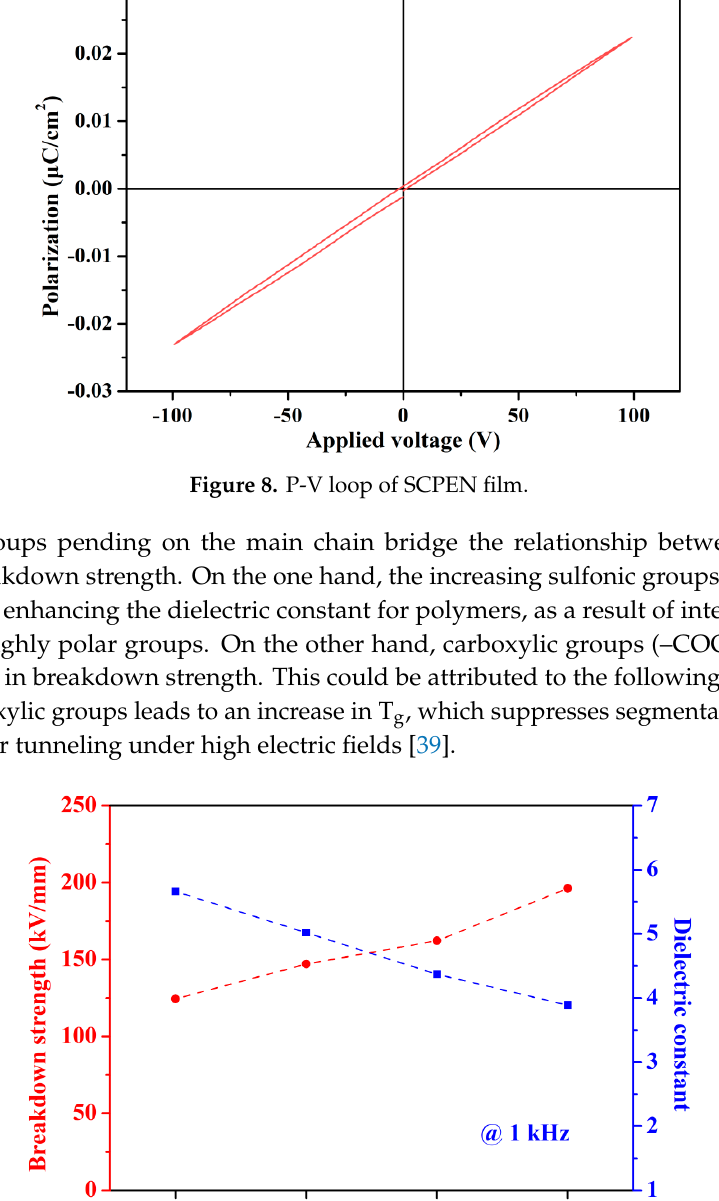
Figure 7. The temperature dependencies of ( a ) dielectric constant and ( b )dielectric loss of SCPEN films at 1 kHz.